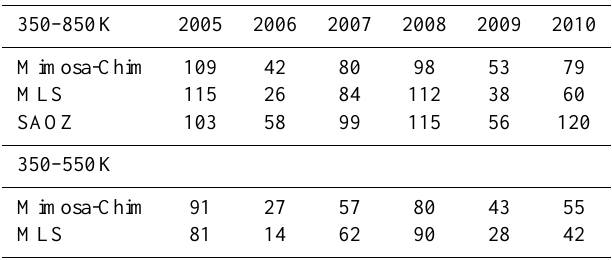
Table 2. The vortex averaged ( ≥ 65 ◦ EqL) accumulated ozone par- tial column loss (DU) estimated in 350–850 and 350–550K from the MLS sampling inside the vortex and corresponding Mimosa- Chim simulations interpolated to the observed points for each win- ter (121 Days from December to March). The SAOZ total column loss computations for the winters are compared to Mimosa-Chim and MLS loss estimates in 350–850K. The calculations for the warm winters 2006 and 2009 are performed for 72 days (from 1 December to 10 February), and 2010 for 90 days (from 1 December to end of February). The maximum loss is found (shown below) around 23–25 March in cold winters. The initial offset between tracer and MLS/Mimosa-Chim ozone is corrected with respect to MLS ozone to account for any biases in ozone loss computations. The column loss is computed from the the daily average of ozone and tracer column found inside the